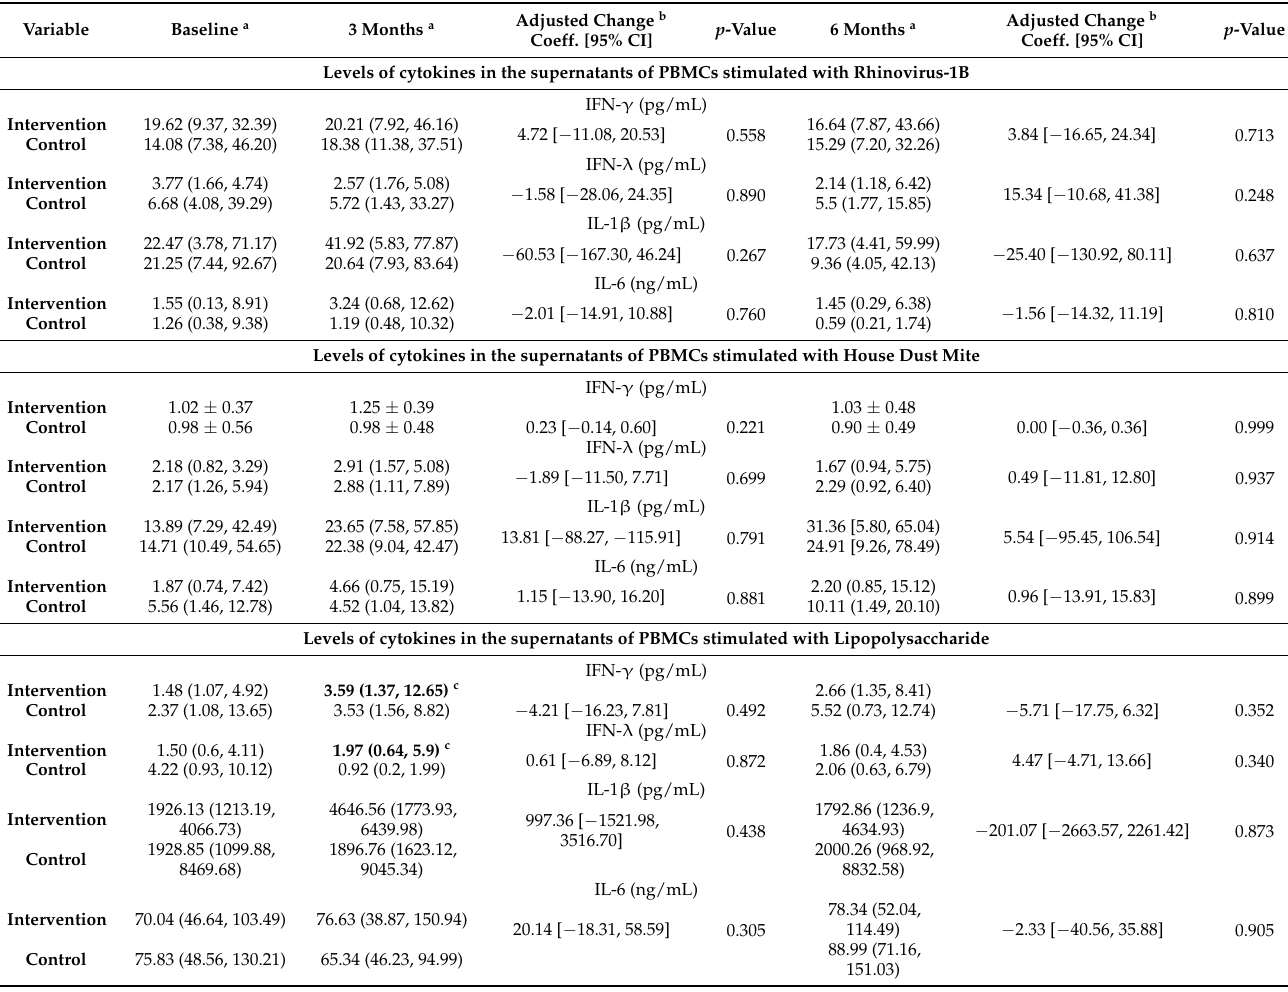
Table 6. Cytokine secretion of PBMCs from children with asthma in response to Rhinovirus-1B, House Dust Mite and